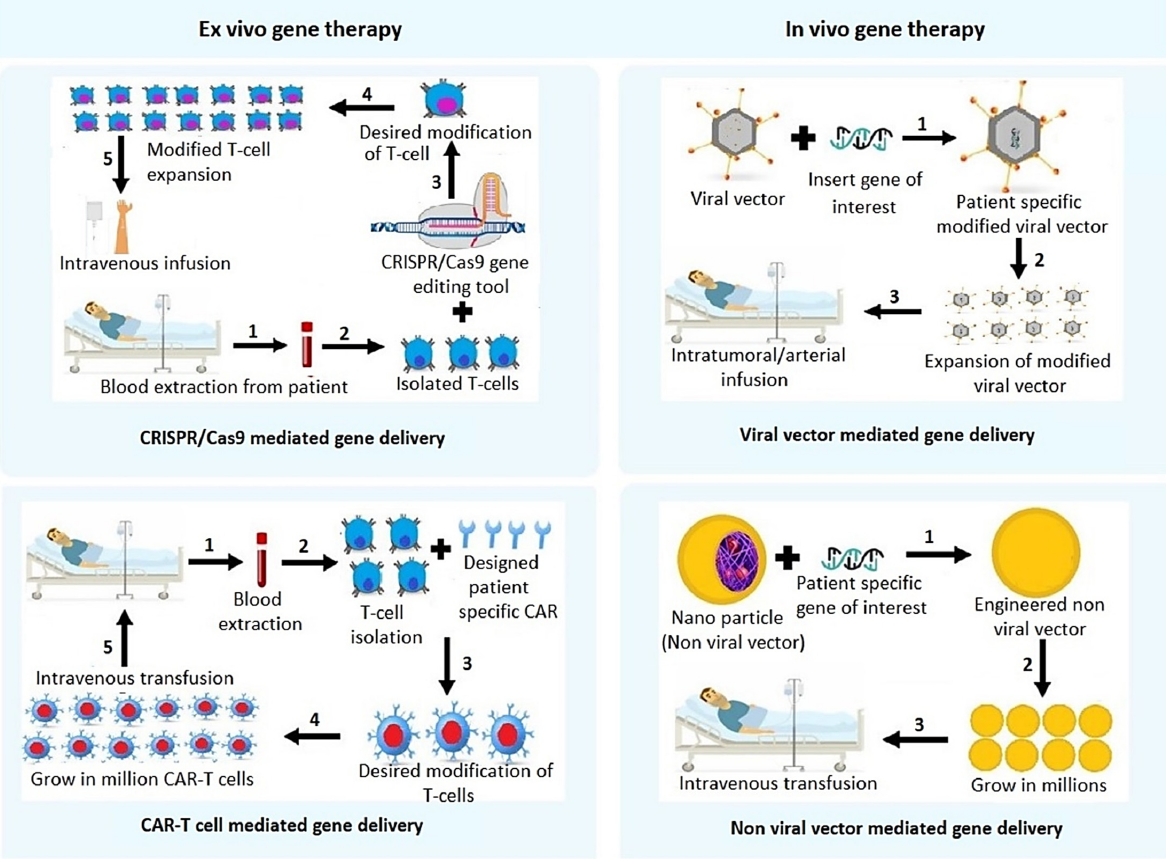
Figure 1. An overview of the gene- and immune-based therapeutic techniques for HCC.